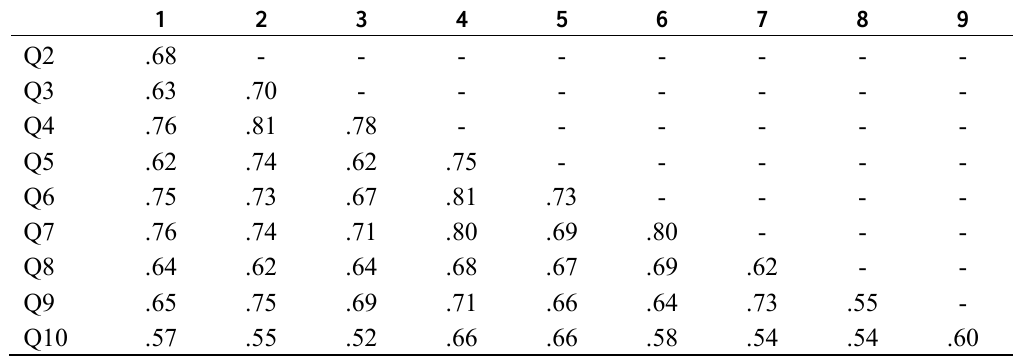
Table 1. Correlation Matrix for the 10 items of the Santa Clara Strength of Religious Faith